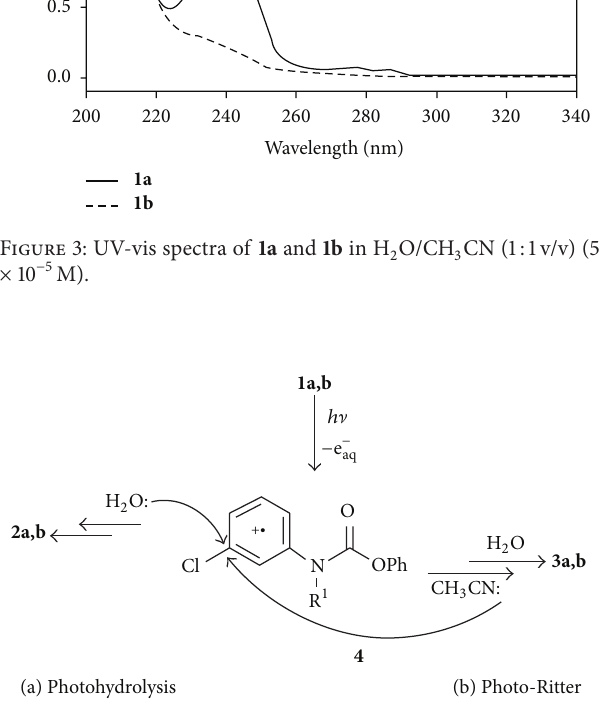
Figure 4: Suggested pathways for photoproducts 2a , b , and 3a , b